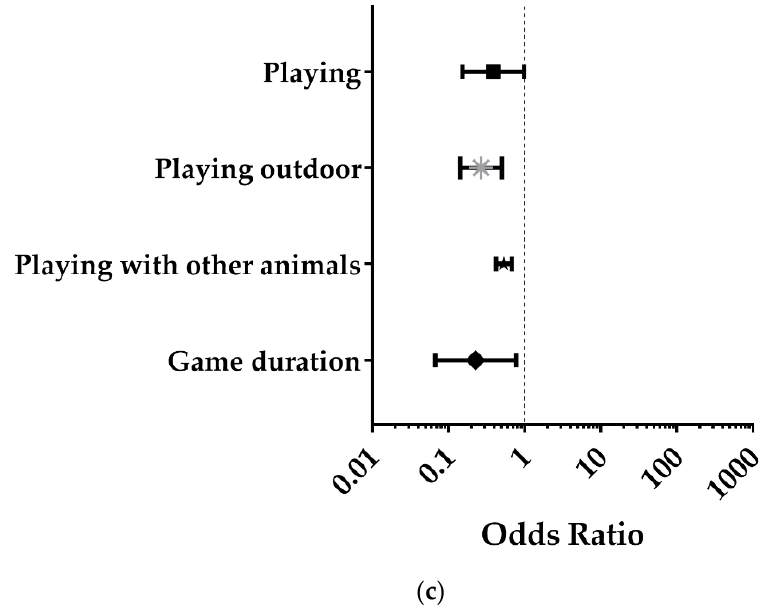
Figure 1. Forest plots of the parameters significantly associated with overweight: results of the univariate analysis (unadjusted OR and 95% CI) for factors related to demographic characteristics and general management of cat ( a ), food management ( b ) and cat behavior ( c ). The detailed description of the variables and the reference categories are shown in Tables S2–S4.